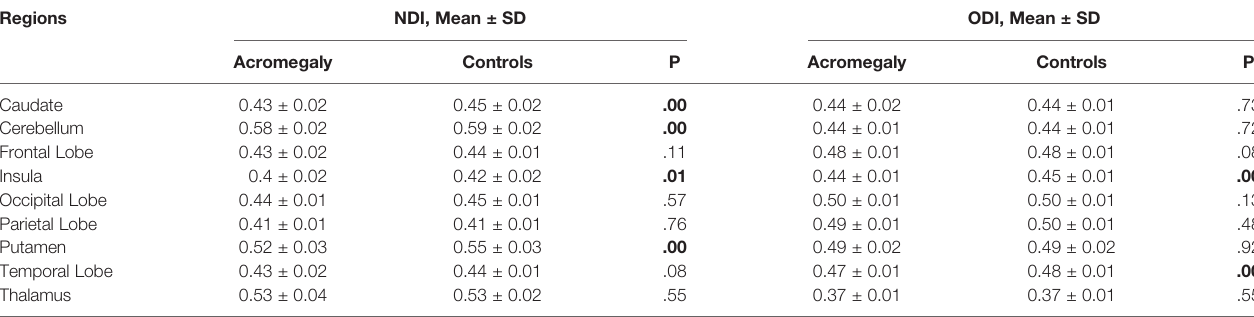
TABLE 2 | NODDI metrics including NDI and ODI in cortex for ROI Analysis between acromegaly and controls. Regions